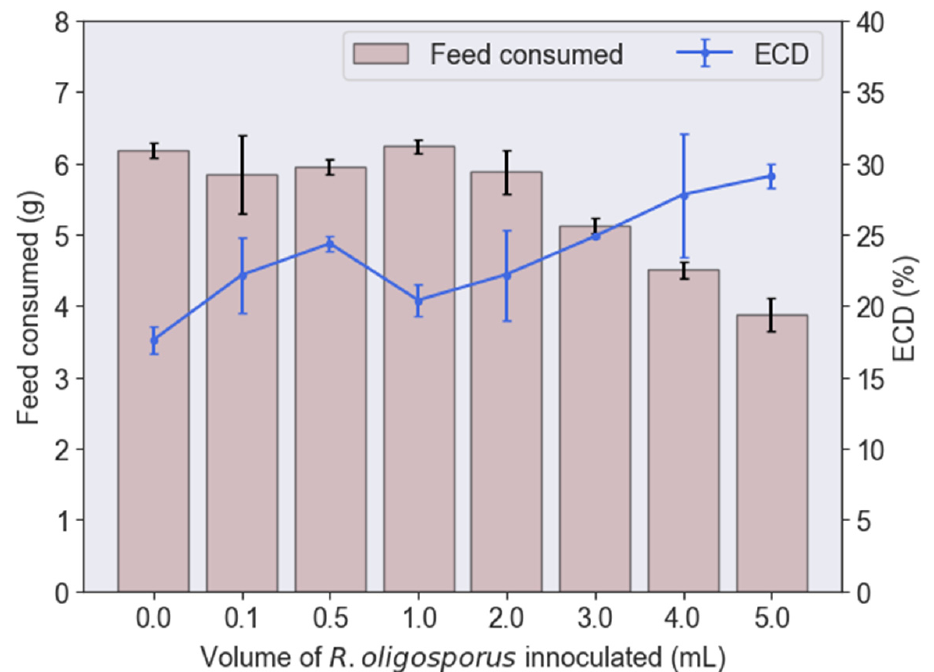
Figure 2. Total feed consumed and the efficiency of conversion of digested feed (ECD) by black soldier fly larvae fed with palm kernel expeller containing various inoculation volumes of R. oligosporus .